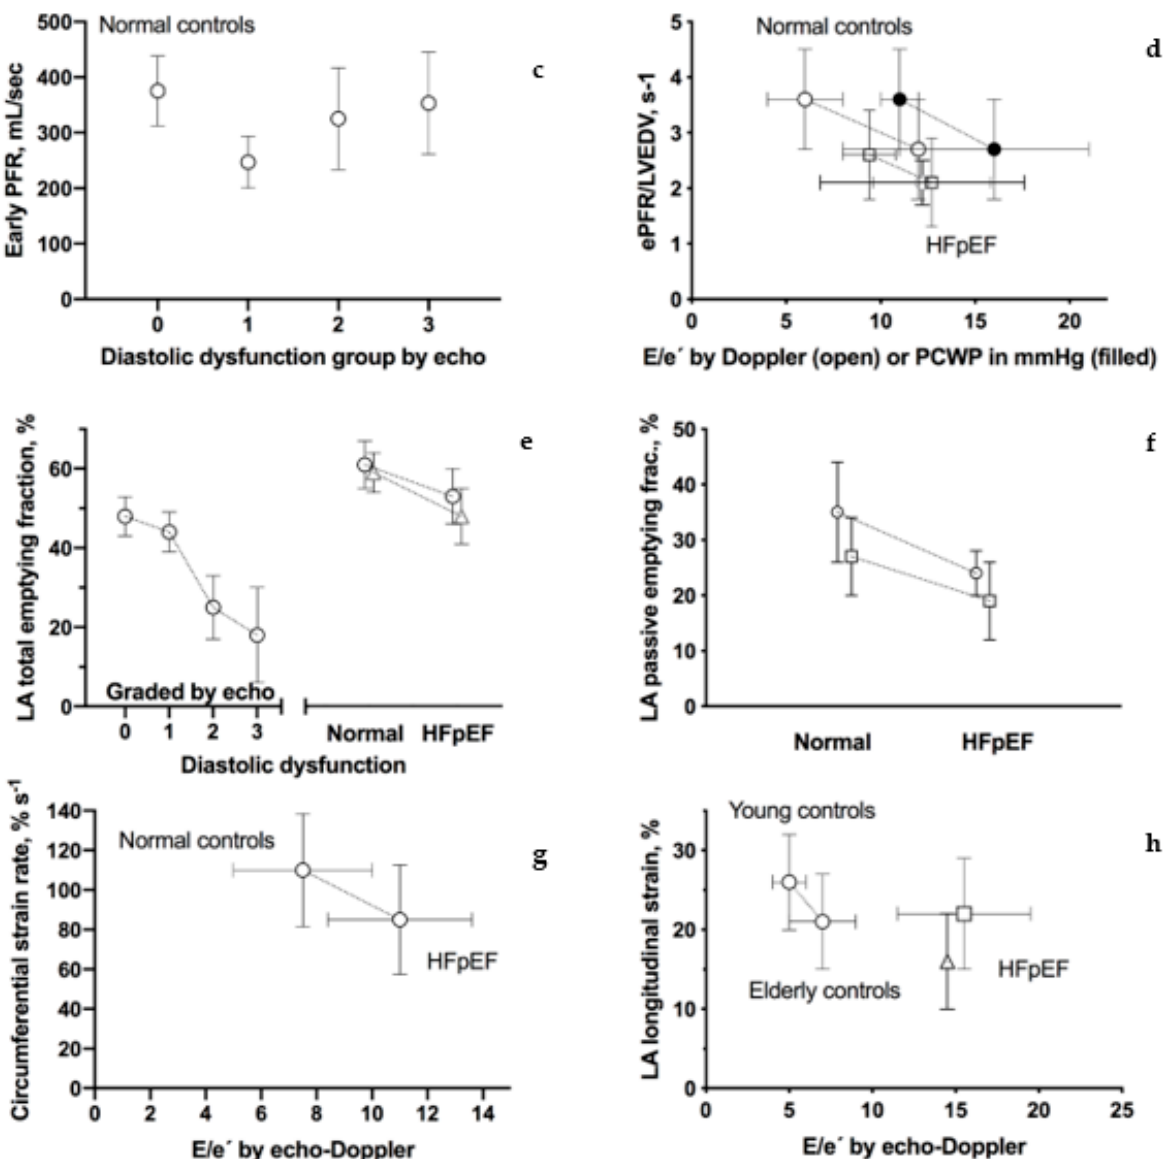
Figure 2. CMR tagging—brief description. Graphic presentation of CMR-assessed parameters of diastolic dysfunction. Connecting lines indicate that estimates come from the same study. References are from the left top corner; ( a ) time to peak untwisting rate (ms) [12]; ( b ) peak change of the torsion shear angle versus volume curve in the early diastole ( − d φ ’/dV’) [13]; ( c ) early peak filling rate (Early PFR, mL/sec) [14]; ( d ) early peak filling rate indexed to LV end-diastolic volume (ePEF/LVEDV, ms) [15,16] and [17] (only patients with reduced diastolic function, please see text); ( e ) left atrium total emptying fraction (%) [14,18,19]; ( f ) left atrium passive emptying fraction (%) [18,19]; ( g ) circumferential-myocardial strain rate from feature tracking (% s − 1 ) [20]; and ( h ) left atrium total longitudinal strain from feature tracking (%) [18,21,22].